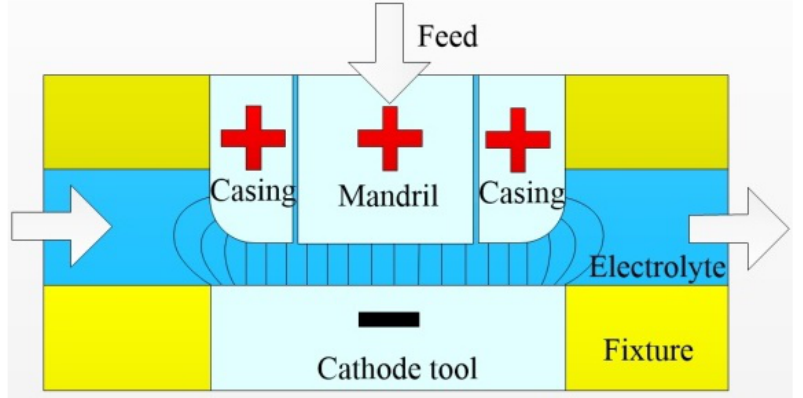
Figure 4. The electric field distribution of the measurement with a casing-type anode.